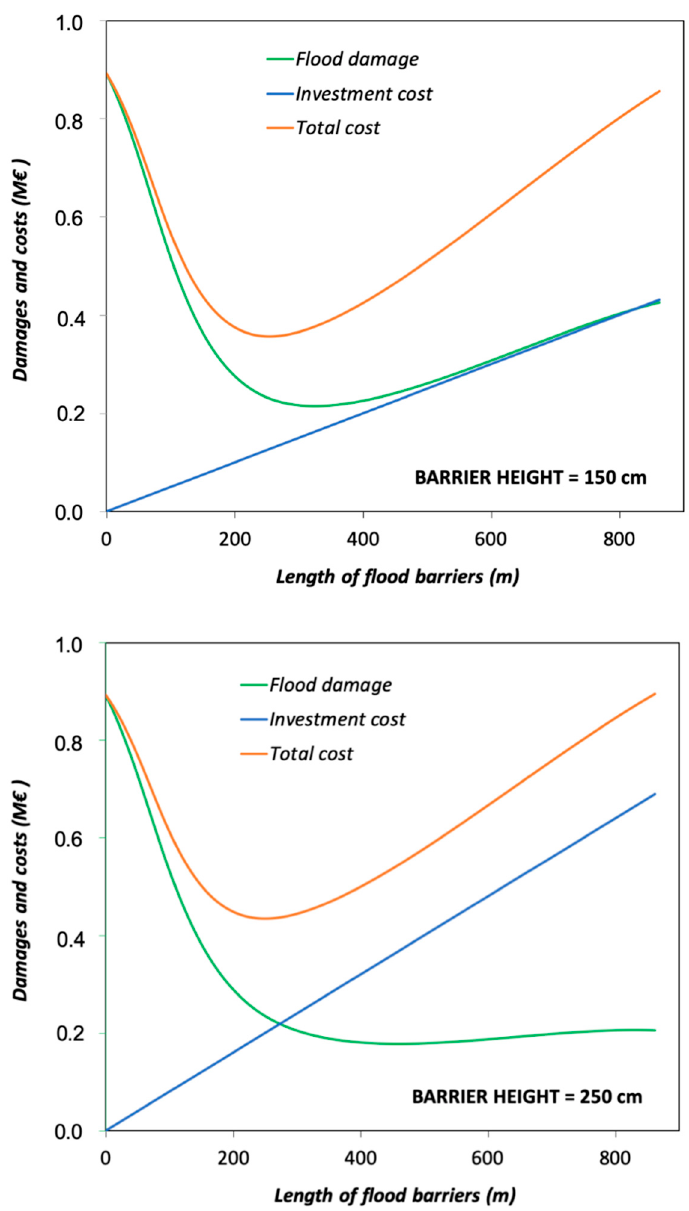
Figure 14. Cost–benefit analysis for scenario 2 (( top ): barrier height = 150 cm; ( bottom ): barrier height 250 cm).